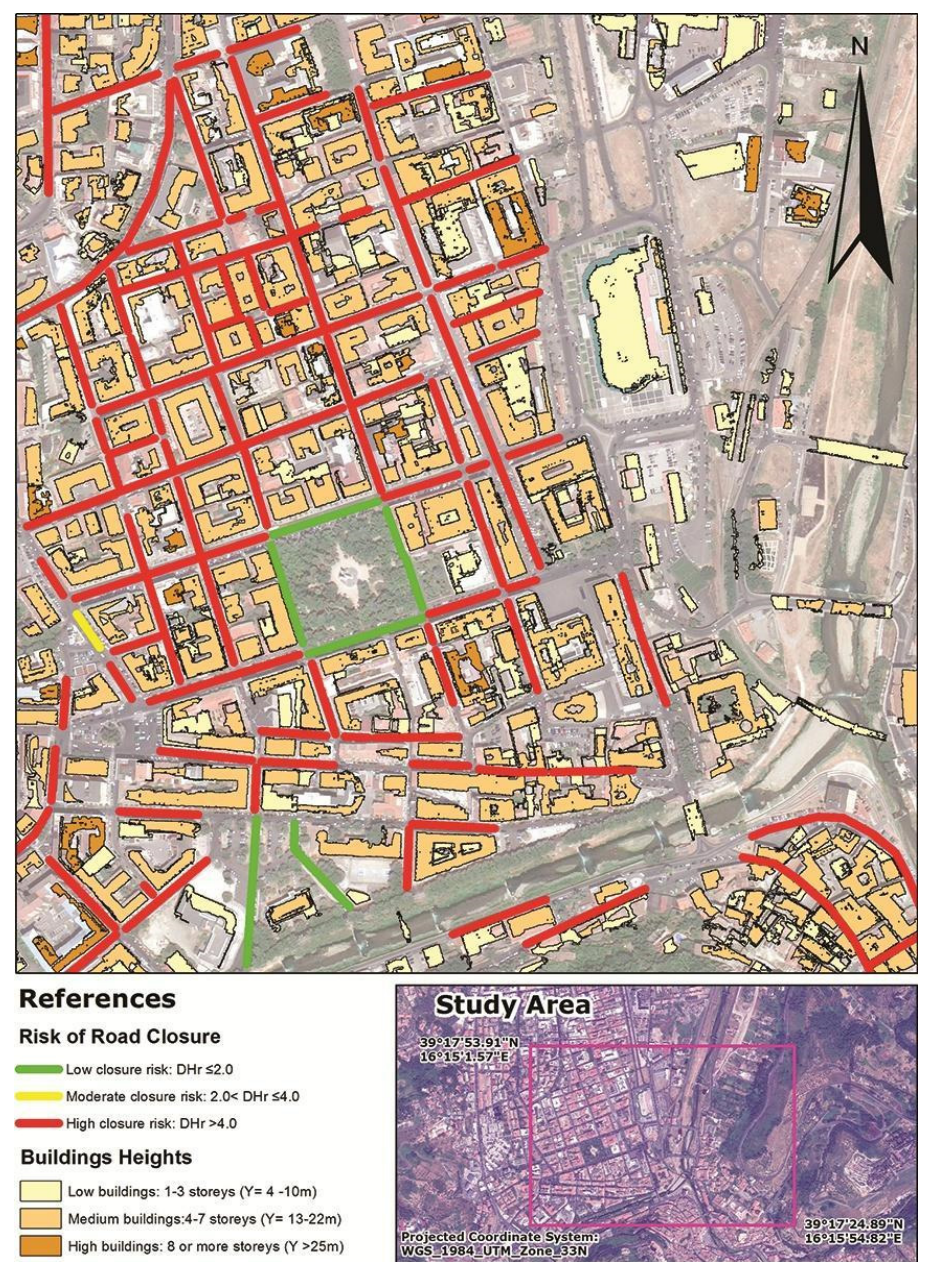
Figure 11. Risk map of the blockage of the roads for a selected area of Cosenza.